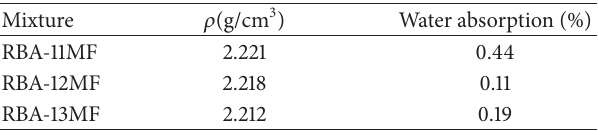
Table 6: Physical